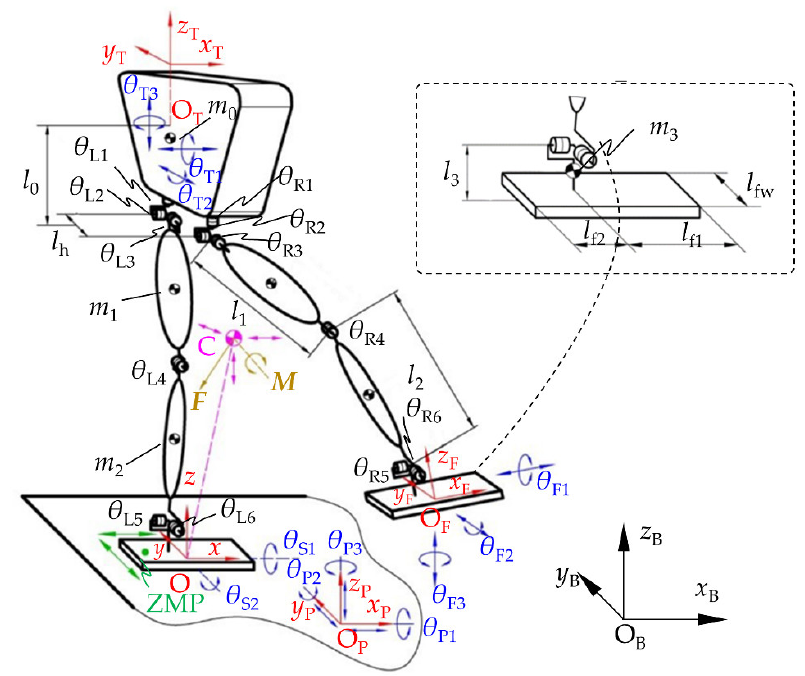
Figure 7. Multi-rigid-body model of the biped robot. Figure 7. multi-rigid-body model of the biped robot. Table 4. Main parameters of the biped robot GoRoBoT-II.